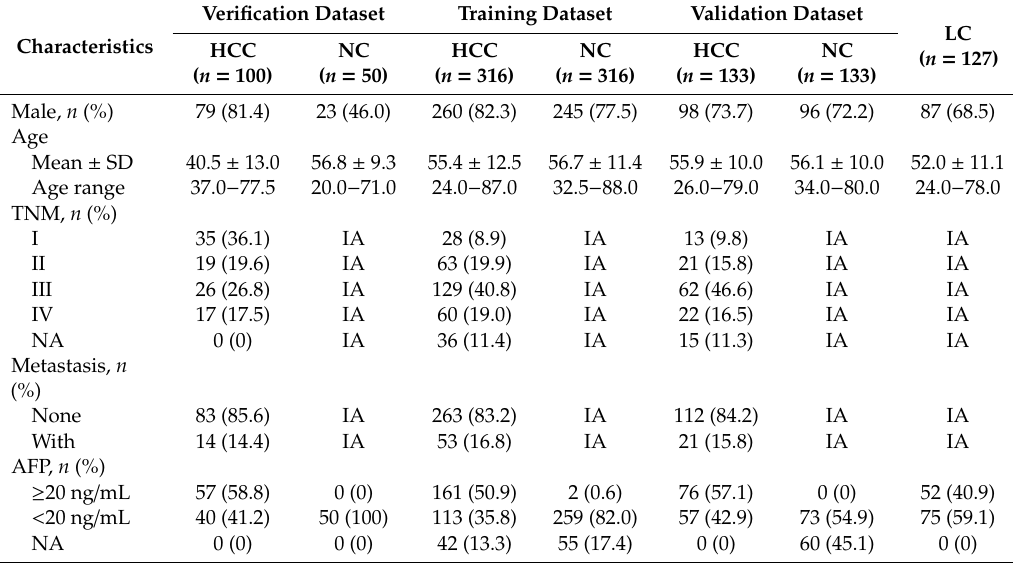
Table 1. Characteristics of